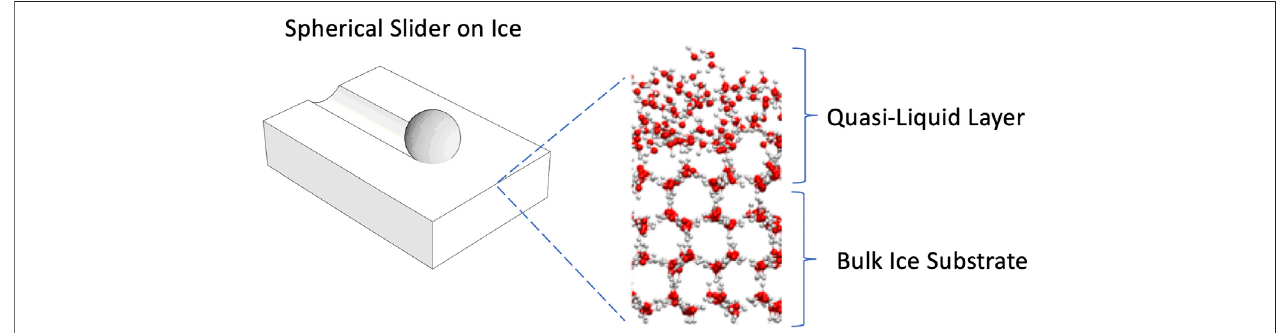
FIGURE 5 | Schematic illustrating the role of the quasi-liquid layer on ice friction (based on Weber et al., 2018; Nagata et al., 2019). Friction on a smooth slider decreases with increasing mobility of the surface water molecules, provided that the bulk-ice substrate responds